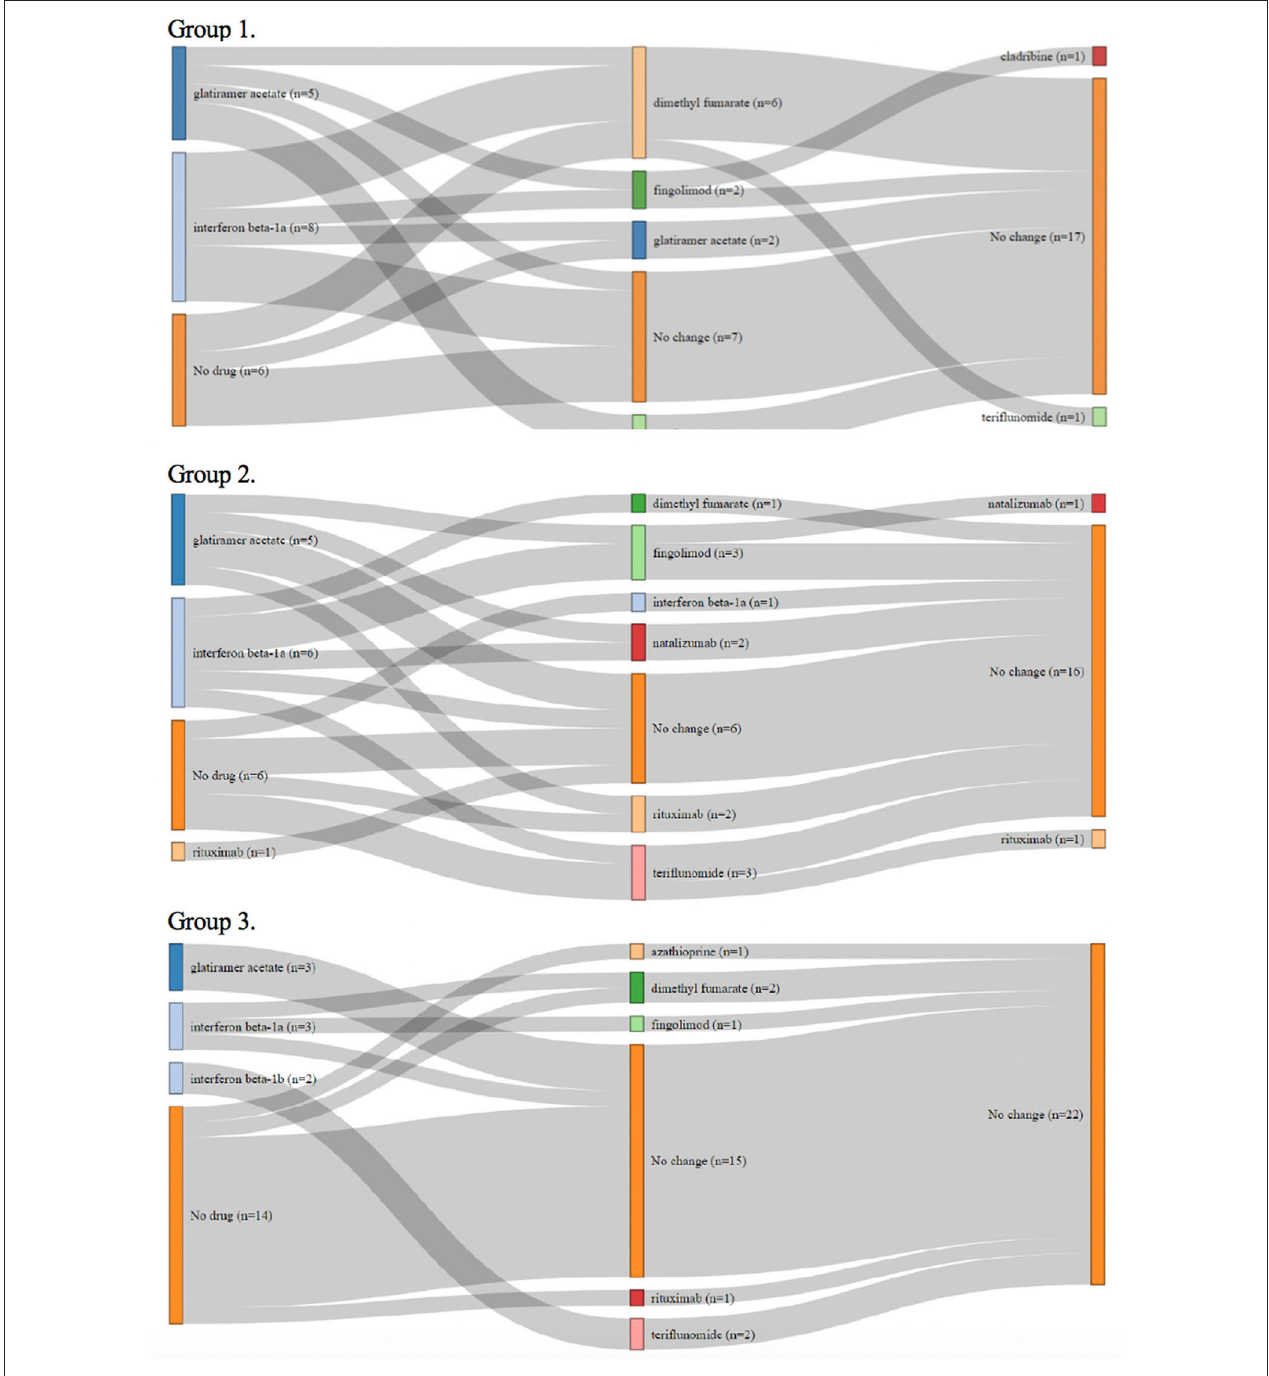
FIGURE 1 | Changes of disease-modifying therapies during the study in the patients without brain atrophy at the study baseline (group 1), in patients with isolated thalamic atrophy (group 2), and in patients with whole brain parenchyma atrophy (group